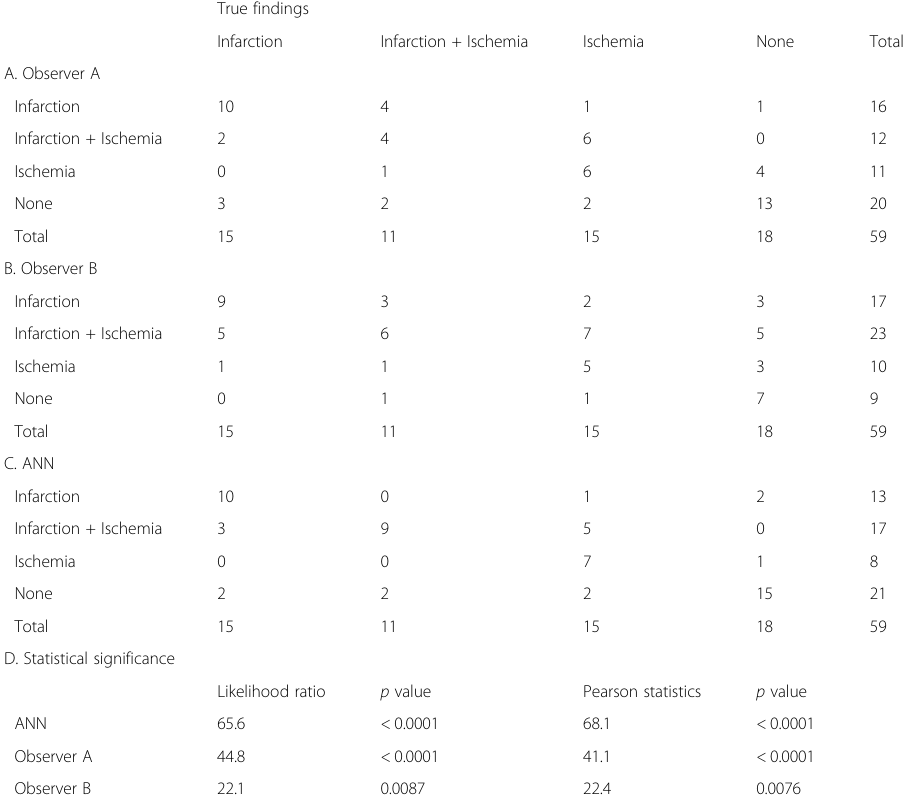
Table 2 Contingency analysis of ANN and two observers